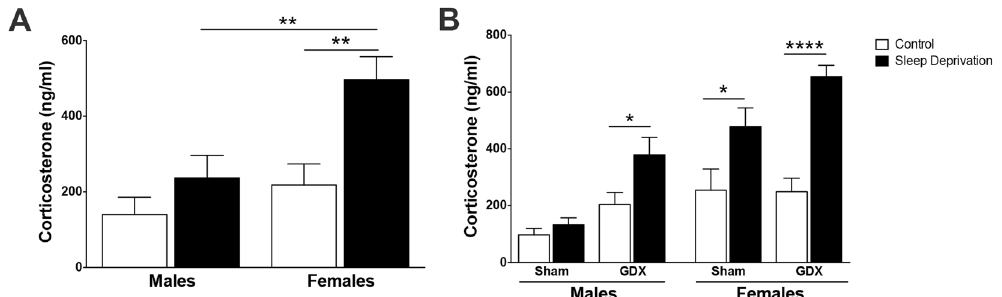
Figure 7. Sleep deprivation elevates corticosterone in female, but not male, animals. Plasma corticosterone in (A) intact or (B) sham-operated or GDX male and female animals that were sleep deprived for 6 h from ZT 0 to ZT 6. All data are mean ± SEM. * P < 0.05, ** P < 0.01, **** P < 0.0001. N = 8 − 11 per